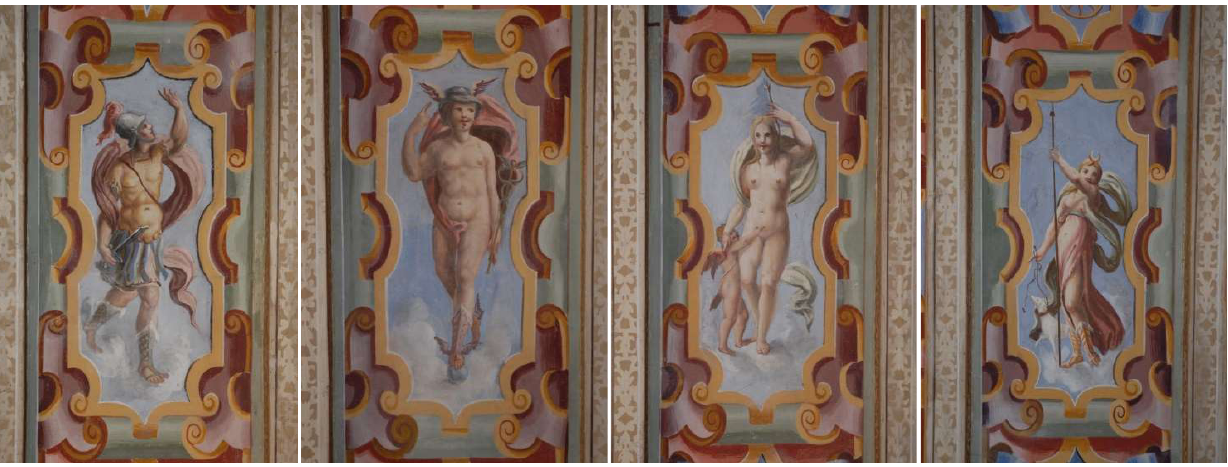
Figure 3. Ceiling details of Rota’s annex. From left to right : Mars, Mercury, Venus, and Diana.